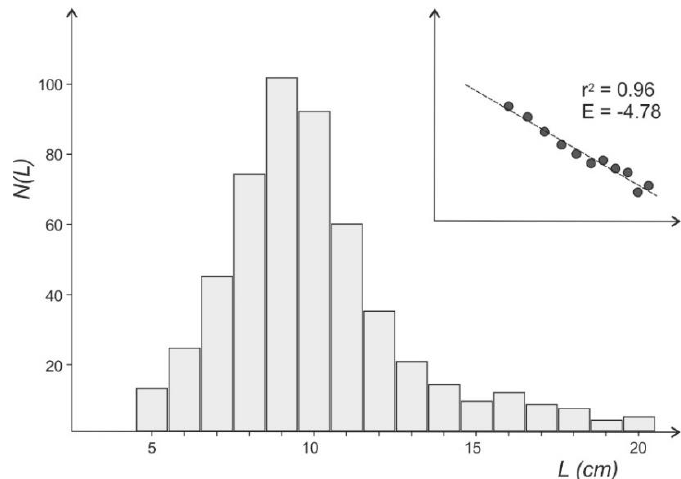
Figure 10. Fracture length distribution measured along the A-1 well. Inset: the log L − logN( L ) plot of the histogram for estimating the length exponent E.